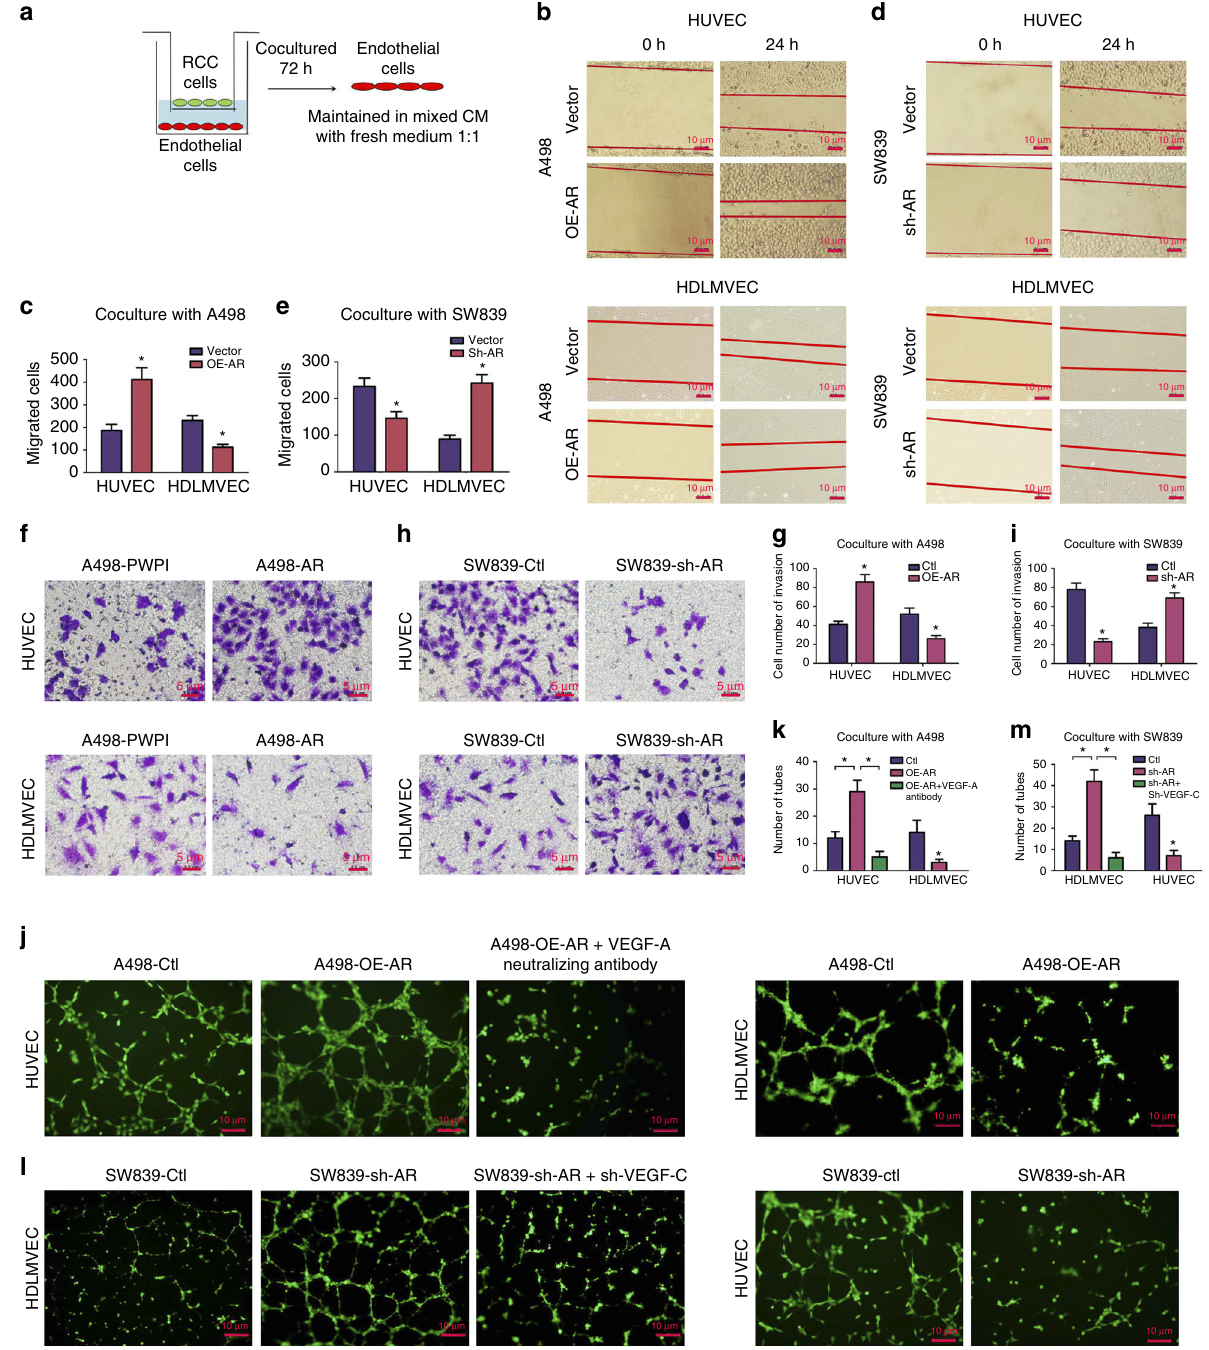
Fig. 3 AR of ccRCC cells in fl uences angiogenesis and lymphoangiogenesis. a Outline of co-culture system. Endothelial cells (HUVEC and HDLMVEC) were co-cultured with ccRCC cells with indicated treatments (with/without overexpression/knockdown of AR) for 72h, and then the endothelial cells were harvested. After harvest, the endothelial cells were maintained in mixed conditioned medium (CM from co-culture system) with fresh media at the ratio of 1:1. b , d Wound-healing assays of HUVEC and HDLMVEC cells co-cultured with A498 b and SW839 d with altered AR expression at indicated time points. Scale bar in b , d 10 μ m. c , e Quantitation of endothelial cells migration in wound-healing assay after co-culture with indicated ccRCC cells as described in b , d . f , h Transwell invasion assay of HUVEC ( upper ) and HDLMVEC ( lower ) after co-culture with A498 cells overexpressing AR ( f ) and SW839 cells with AR knocked down ( h ). After 24h, the invaded cells were stained and fi ve random fi elds per well were analyzed. Scale bar in f , h , 5 μ m. g , i Quantitation of the transwell invasion described in f , h . j A representative image of tube formation assays of HUVEC and HDLMVEC after co-culture with A498 overexpressing AR. The HUVEC cells during coculture with A498 cells were also blocked with VEGF-A neutralizing antibody (R&D Systems) at the concentration of 0.08 µ g/ml. The endothelial cells were pre-stained with Calcein AM at the concentration of 2 µ M and monitored with fl uorescence microscope. l Tube formation assay of HUVEC and HDLMVEC after co-culture with SW839 cells with AR knockdown. The SW839 cells were infected with lentivirus for AR and sh-VEGF-C were used for co-culture with HDLMVEC cells for the rescue assay. Scale bar in j , l , 10 μ m. k , m Quantitation of the tube number described in j , l . The functional assays were all replicated four times. * p < 0.05, was considered statistically signi fi cant by t -test for two groups and ANOVA for more than two